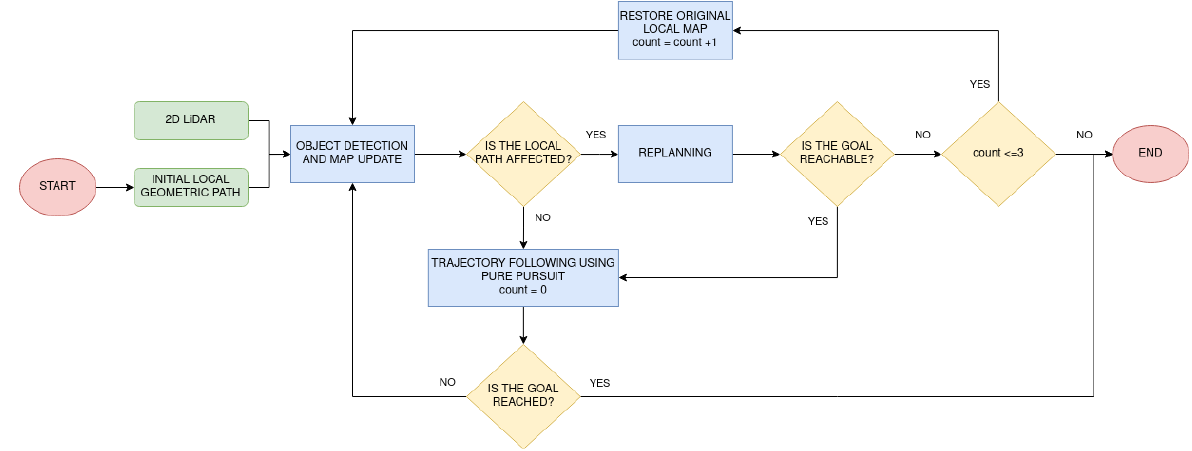
Figure 6. Robot plan execution including dynamically detected objects. The second robot behavior occurs when the robot needs to traverse a narrow passage.